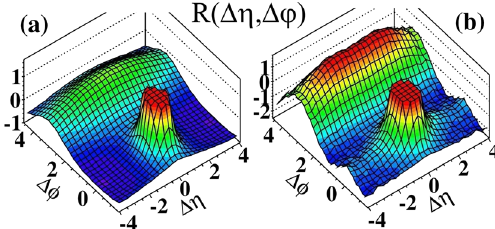
Fig. 1 The R (Δη,Δϕ) functions measured by the CMS Collaboration for inclusive minimum bias events ( a ) and high-multiplicity events, ( N of fline ≥ 110 ) ( b ), for charged particles (Fig. 7b and d, respectively, trk in Ref.